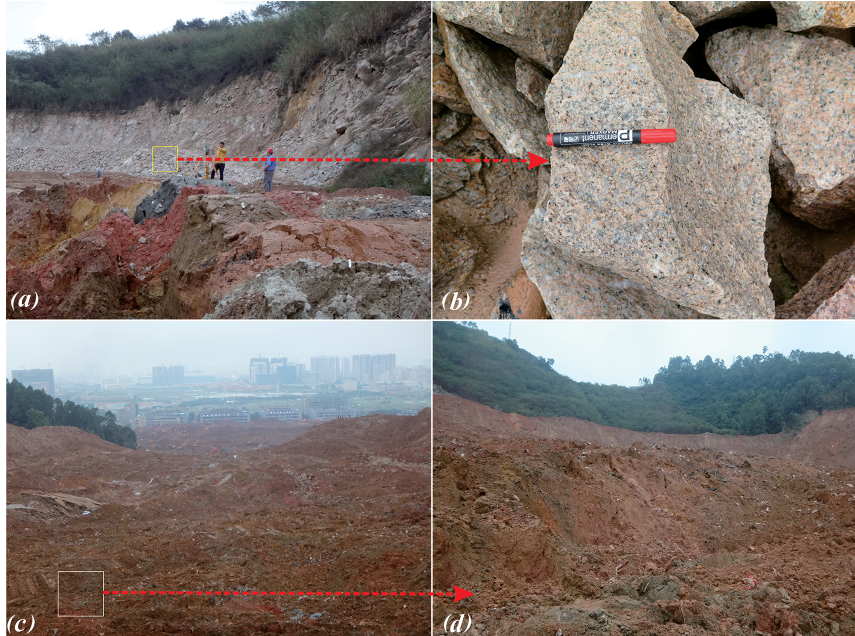
Figure 2. Photos of the rock and soil specimen collected from the displaced material. (a) Exposed granite rock near the flowslide scarp; (b) close view of the granite rocks; (c) displaced material in the zone of depletion; (d) materials in the flowslide source